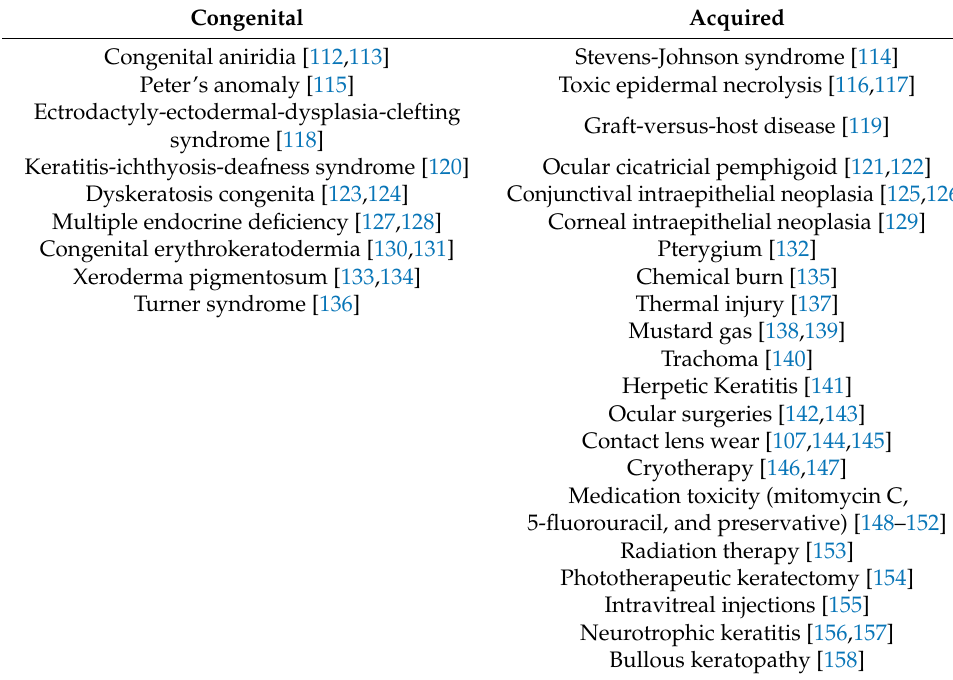
Table 2. Etiologies of